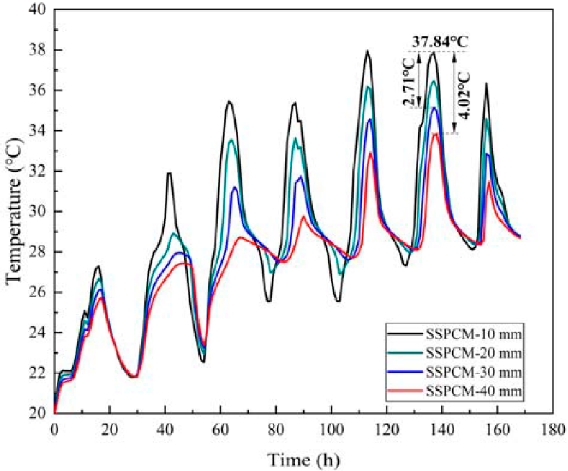
Figure 11. The internal surface temperature of the SSPCM layer with different SSPCM layer thicknesses.